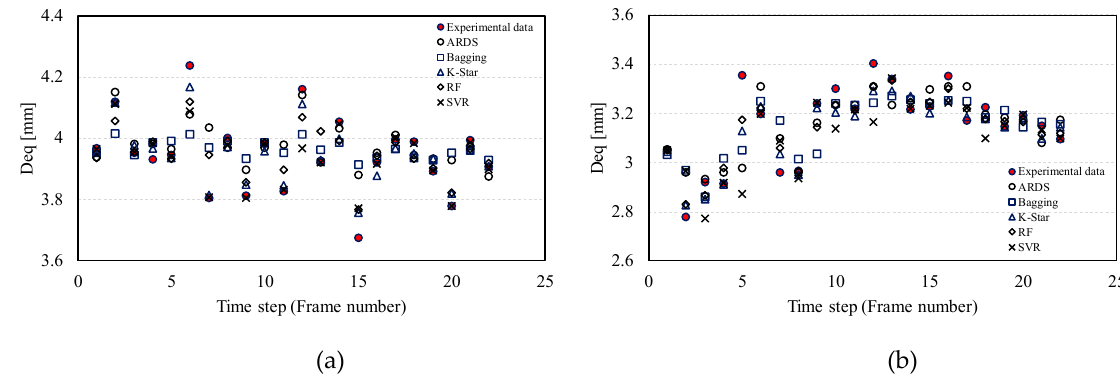
Figure 9. Comparison among equivalent diameters by means of time series; ( a ) Model 1—bubble 1; ( b ) Model 2—bubble 12.